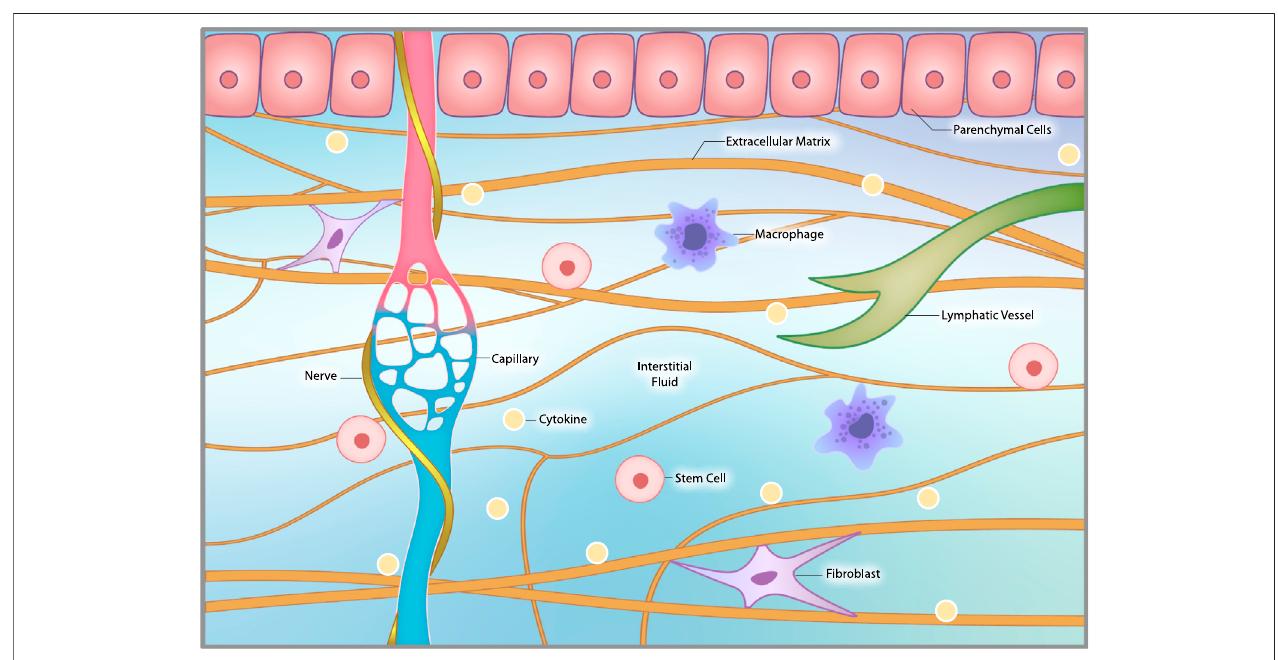
FIGURE 3 | The interstitial microenvironment. The interstitium consists of extracellular matrix (ECM), interstitial fl uid, interstitial cells and nerve fi bers, including sympathetic nerves,that coilaroundlocal capillaries. TheECM provides structural support toorgans and tissues. Interstitial fl uid arises from theblood bydiffusing outof capillaries. It circulates through the interstitium, interacts with interstitial cells and then is drawn into lymphatic channels and back into the venous circulation. Interstitial cells include macrophages, fi broblasts, occasional stem cells and other related cells that vary by location.